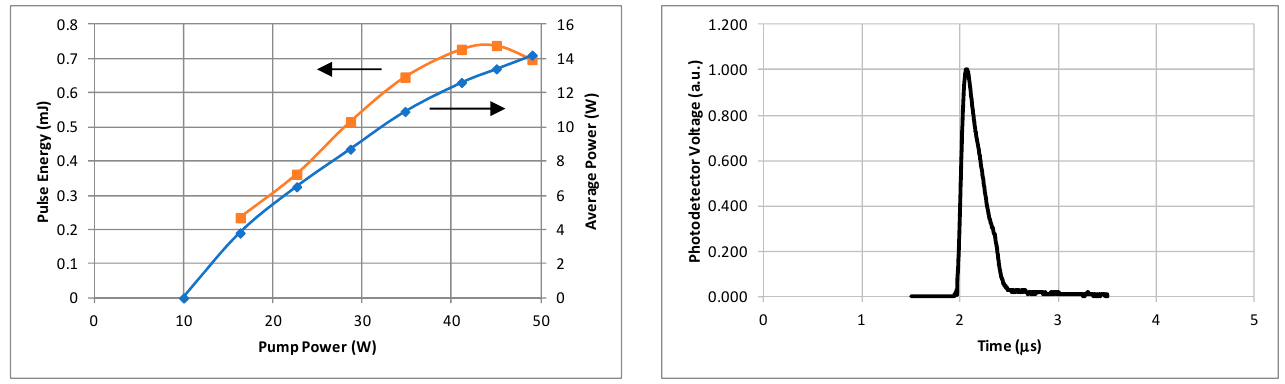
Figure 4. Energy vs. pump power and pulse shape at 0.75 mJ and 16 kHz with 200 ns pulses.